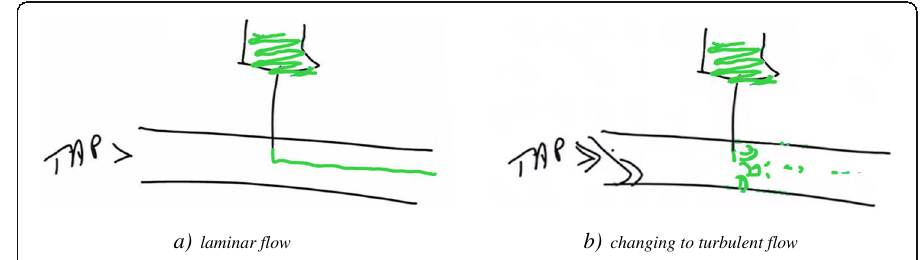
Fig. 1 Obeng fluid dynamic analogy for change (Obeng,